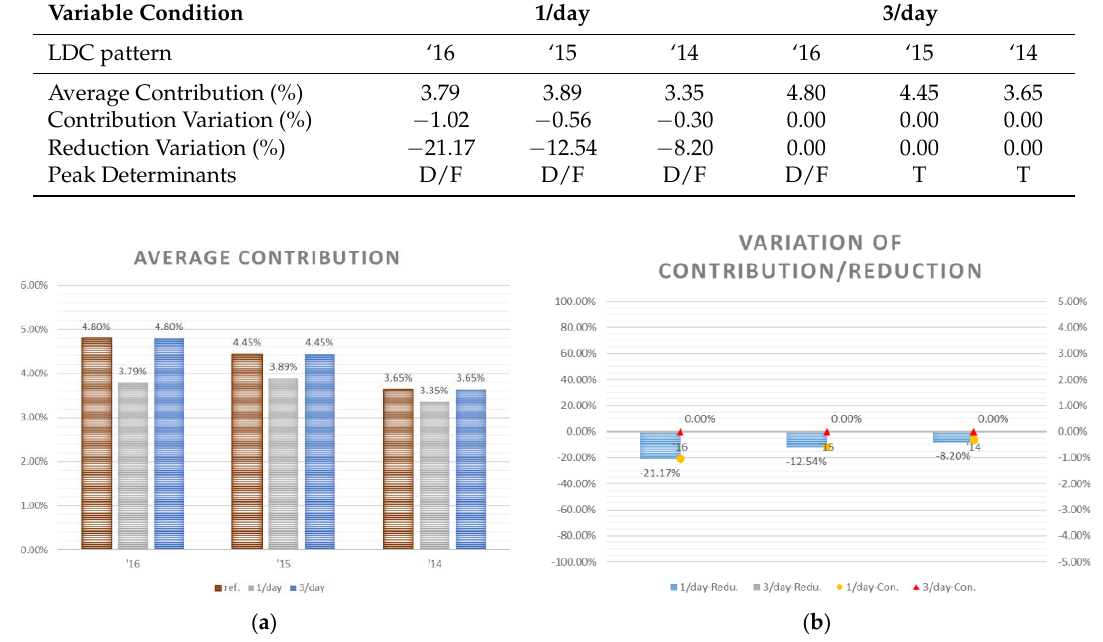
Figure 5. Sensitivity simulation results of the number of available dispatches constraint: ( a ) Average contribution; ( b ) Variation of contribution and reduction.